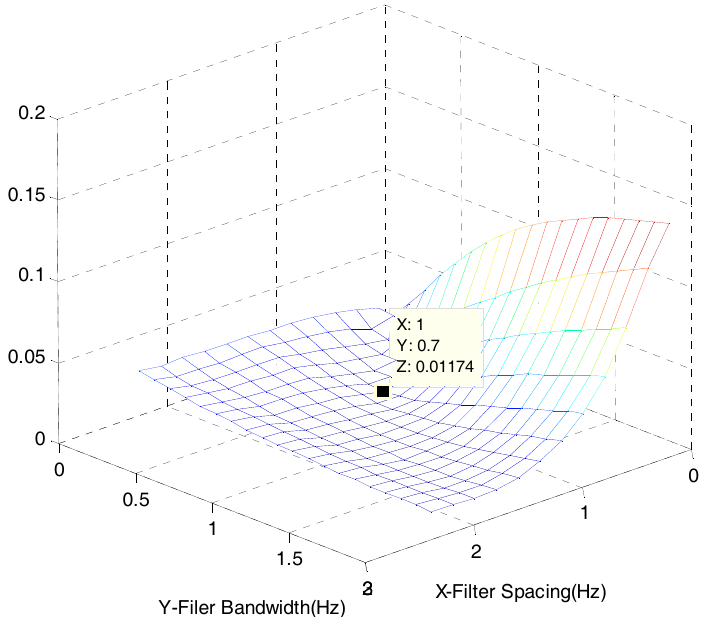
Figure 7. RE results for 10 filters.